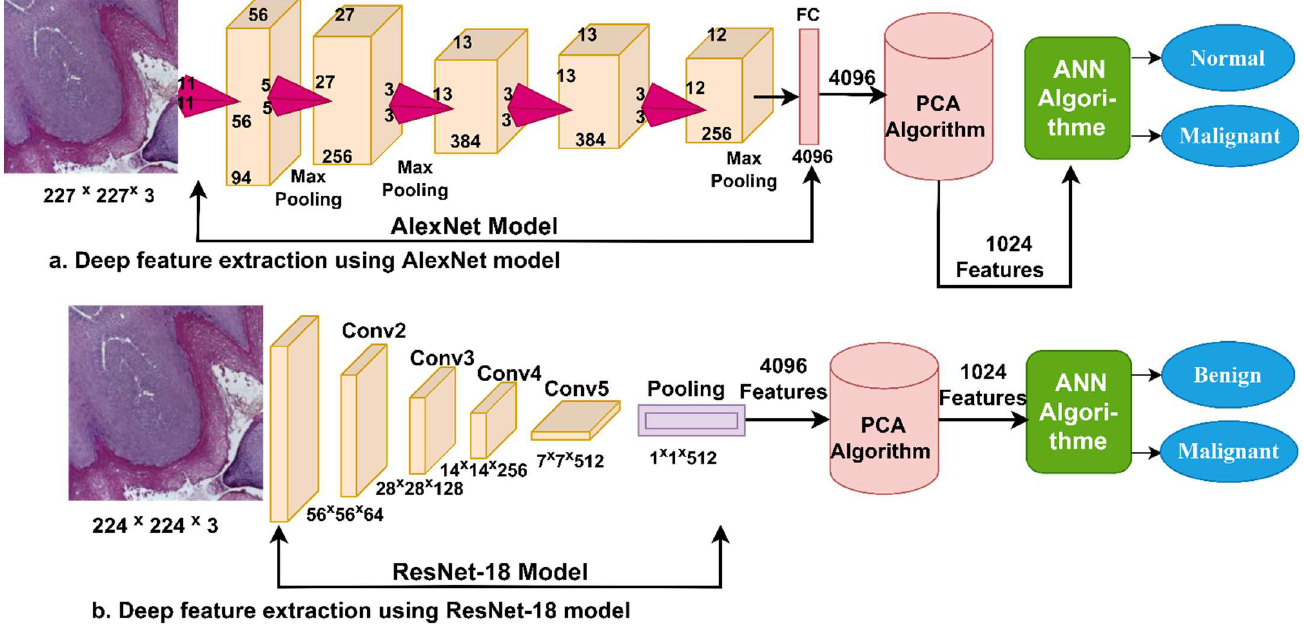
Figure 5. Methodology for histopathological image diagnosis of oral cancer using ANN based on deep feature AlexNet and ResNet-18 models.